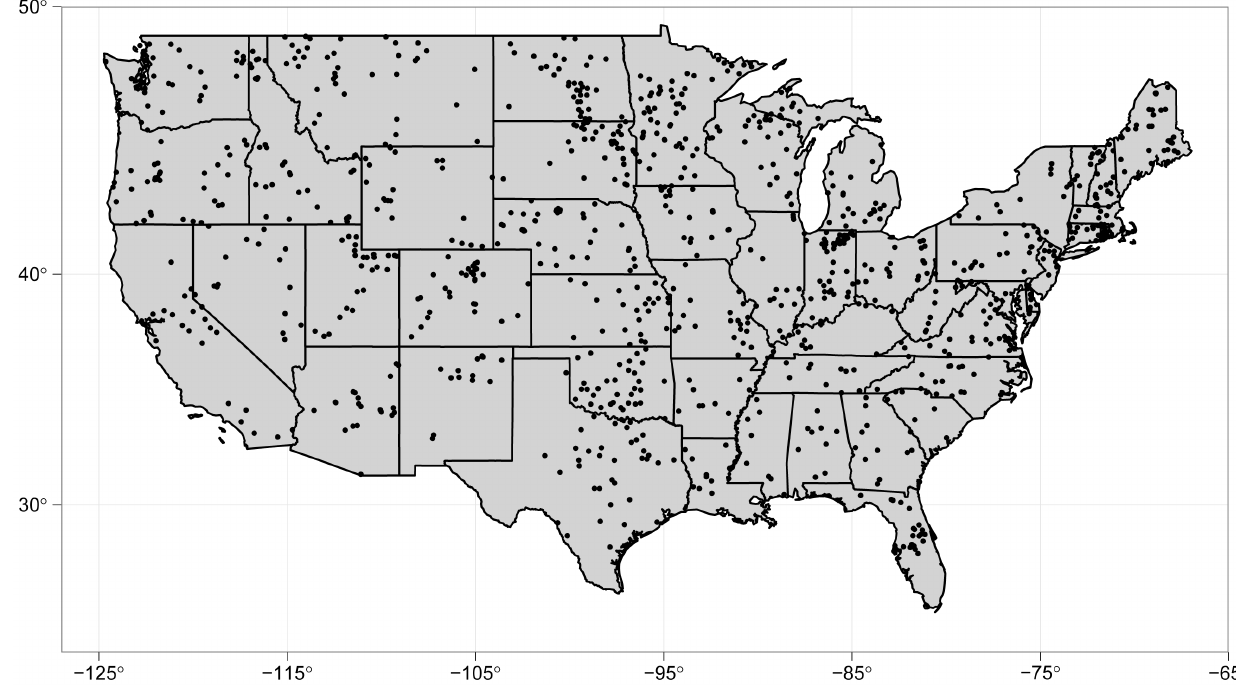
Figure 2. Distribution of lakes. Distribution of lakes that were sampled for the 2007 U.S. National Lakes Assessment.